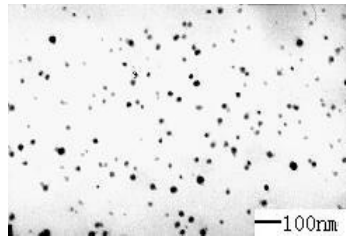
Figure 7. Not supersonic Figure 8. Supersonic 1